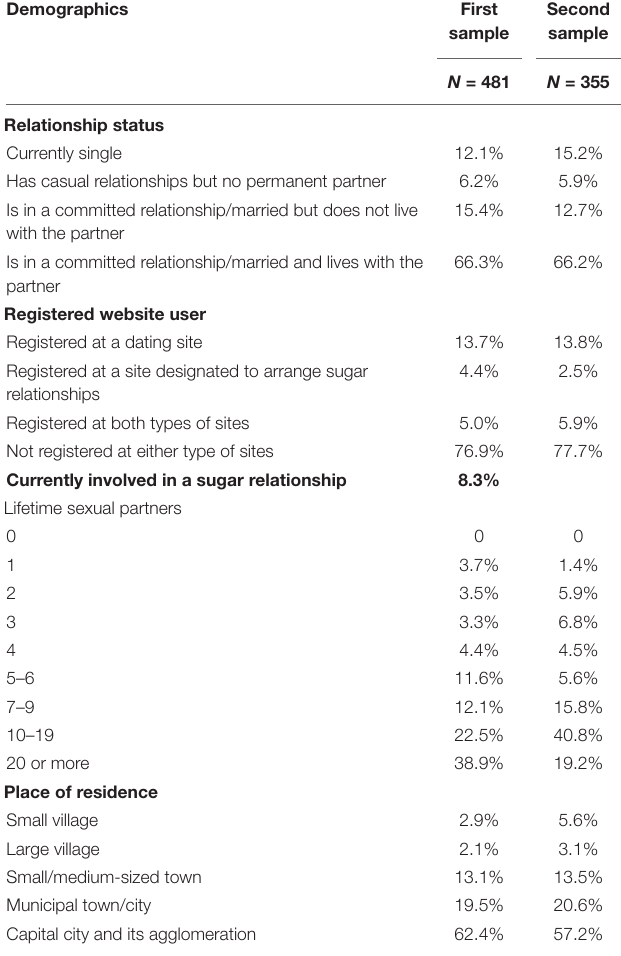
TABLE 1 | Demographic data of the two samples of the